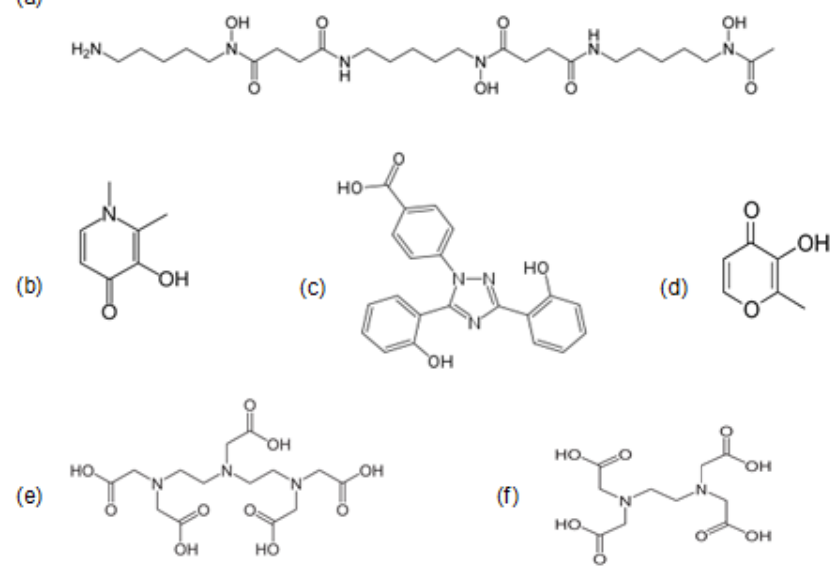
Figure 3. The chemical structure of the main chelating drugs in clinical use. The main iron chelating drugs which are commercially available for the treatment of transfusional iron overload are ( a ) deferoxamine, ( b ) deferiprone and ( c ) deferasirox. The ( d ) iron complex of maltol is used for iron deficiency. The other two chelating drugs ( e ) DTPA and ( f ) EDTA are mainly used for the detoxification of xenobiotic metals.